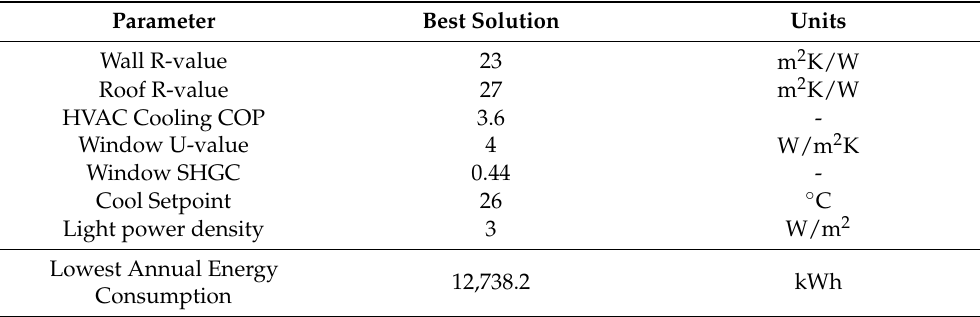
Table 8. Optimal design variables obtained with Bayesian